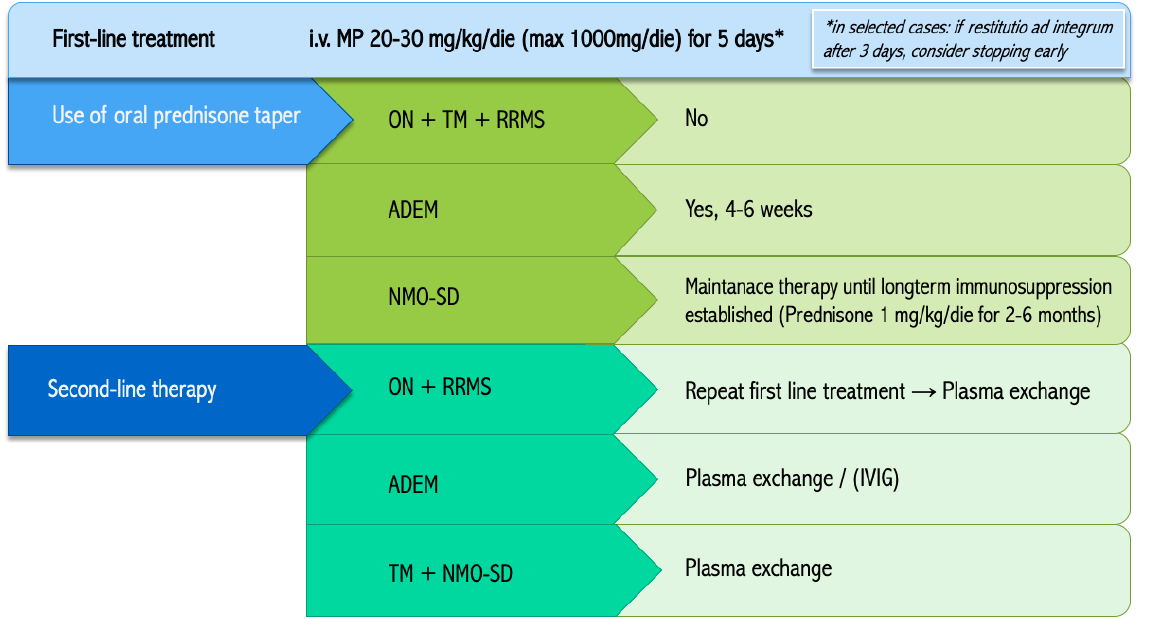
Figure 1. Treatment algorithm in pediatric acute demyelinating syndromes.